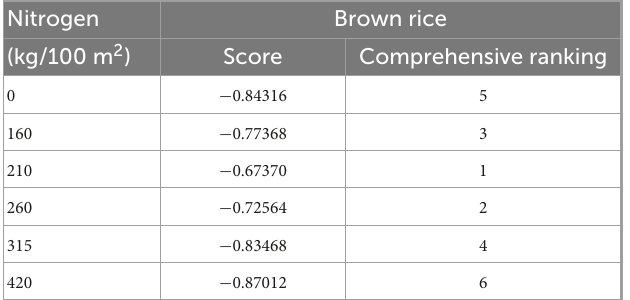
TABLE 5 Scores of brown